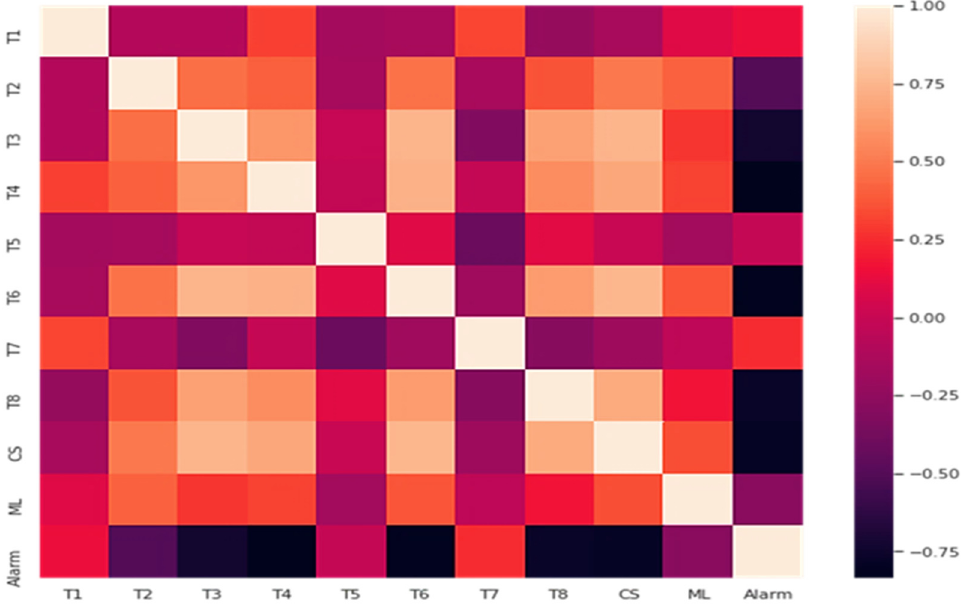
Figure 8. Correlation matrix.